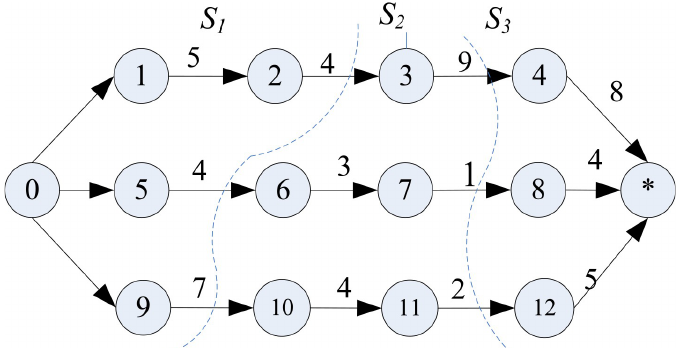
Figure 2. An illustration of the decomposition scheme for a JSP with 3 jobs and 4